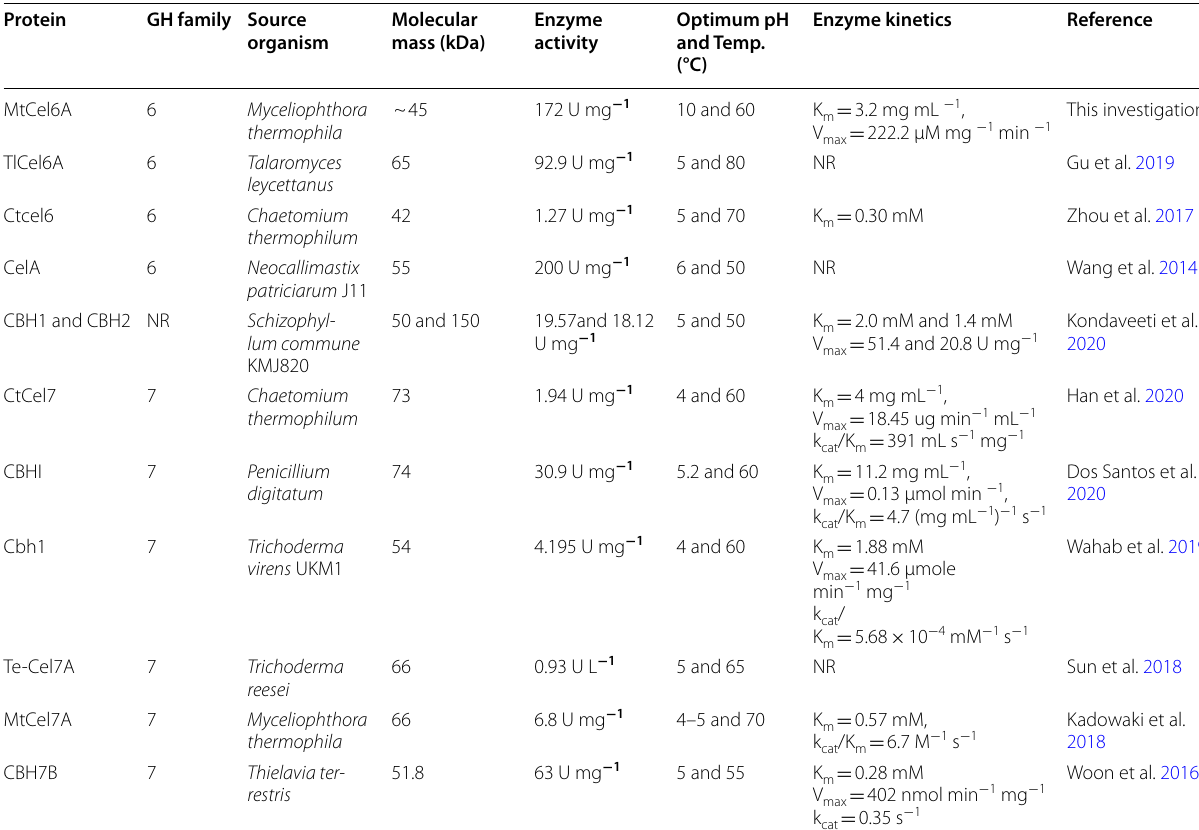
NR Not reported